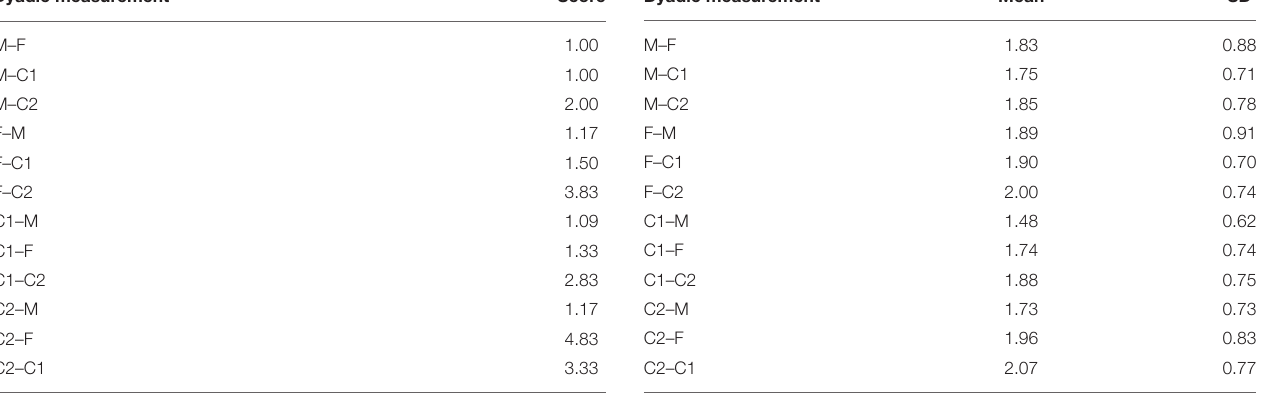
TABLE 1 | Raw dyadic measurements of the family of interest (M, mother; F, father; C1, oldest child; C2, youngest child). Dyadic measurement